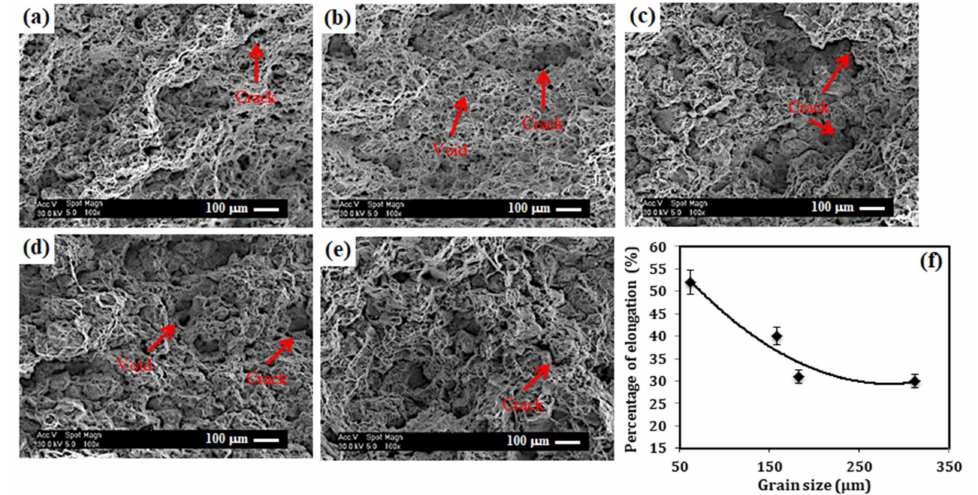
Figure 5. SEM images of rupture surface of Fe-40Ni-24Cr after creep test at 800 ◦ C and 100 MPa; ( a ) as-received and heat-treated sample at different temperatures: ( b ) 1050 ◦ C, ( c ) 1200 ◦ C, ( d ) 1225 ◦ C and ( e ) 1250 ◦ C; ( f ) percentage of elongation versus grain size of heat-treated